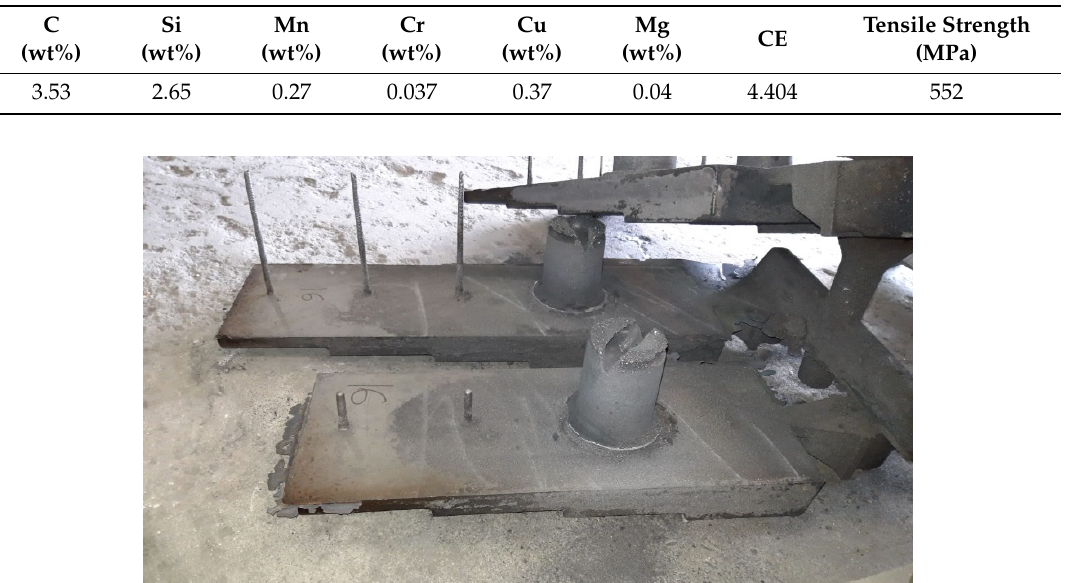
Table 1. Ductile iron chemical composition.